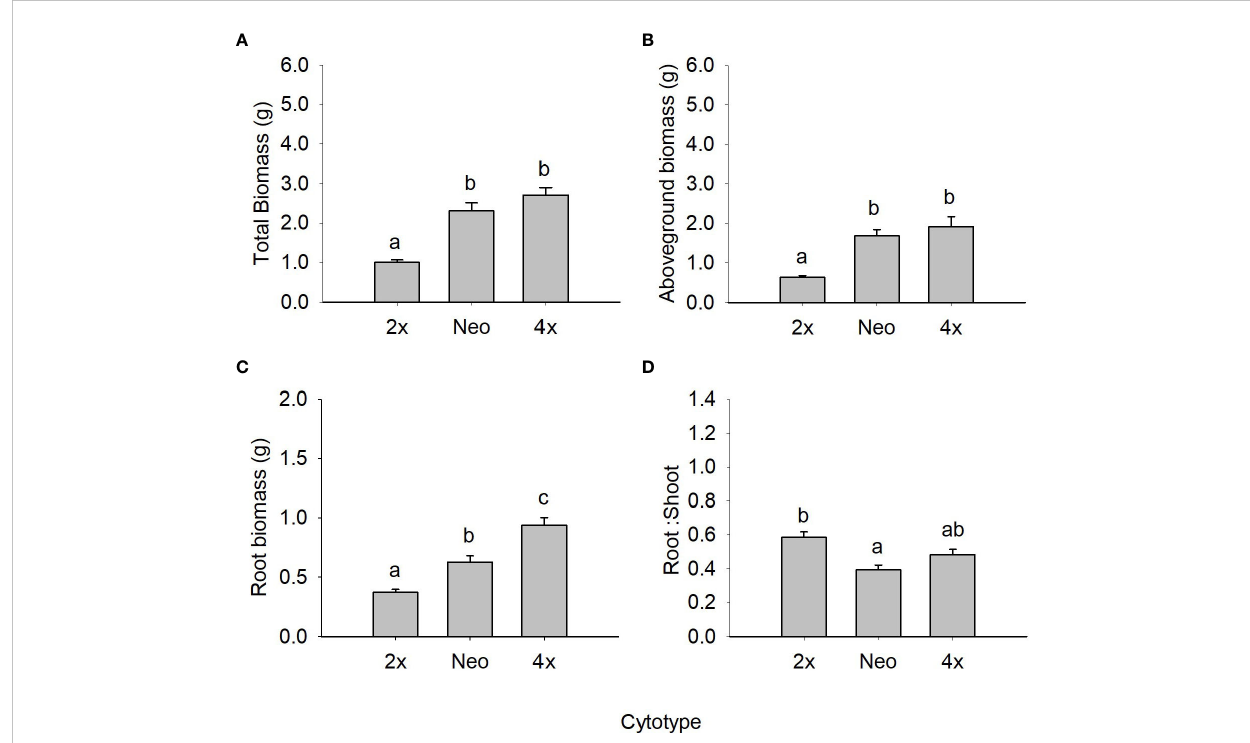
FIGURE 1 Mean (± SE) for total biomass (A) , aboveground biomass (B) , root biomass (C) and root to shoot ratio (D) of diploids, neotetraploids and tetraploids Jasione maritima var maritima of contact zone populations grown under control conditions. Signi fi cant differences at P < 0.05 among cytotypes are indicated by different